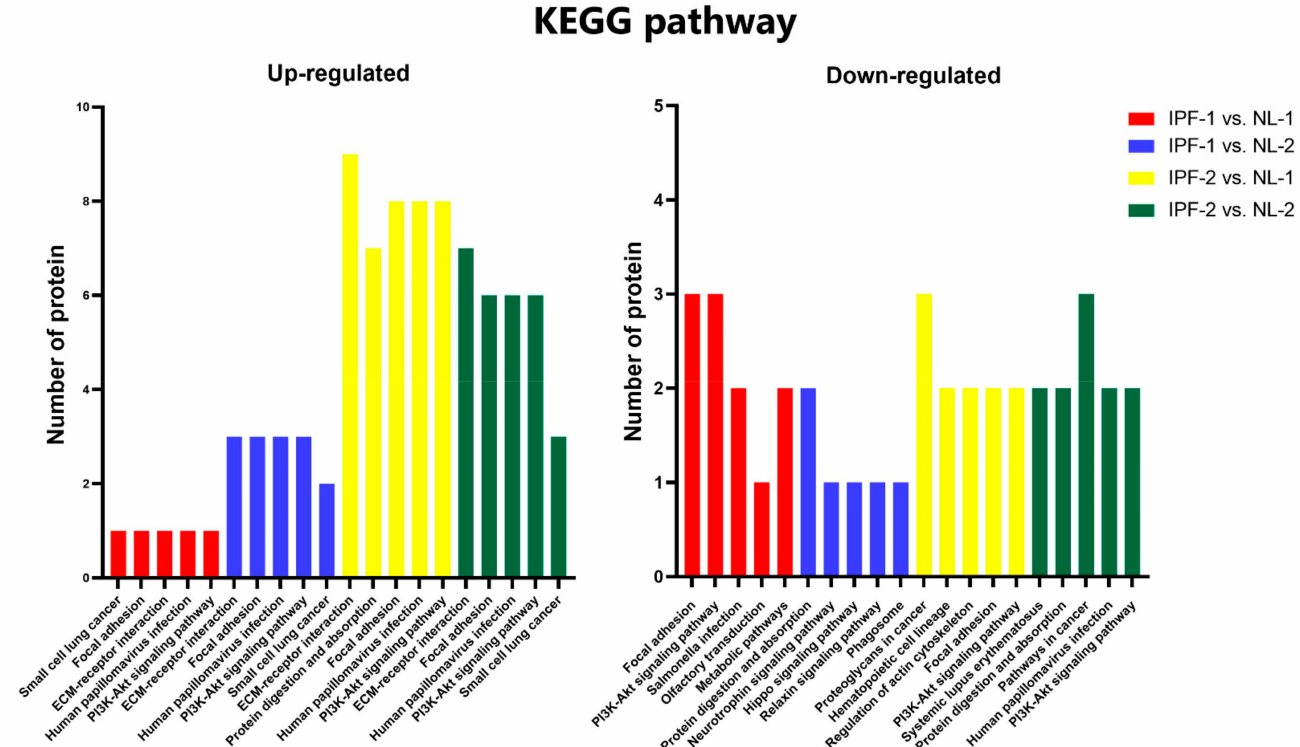
Figure 5. KEGG pathway enrichment analysis of differentially expressed proteins. Up- and down-regulated proteins are involved in the top five KEGG pathways. IPF, idiopathic pulmonary fibrosis; NL, normal